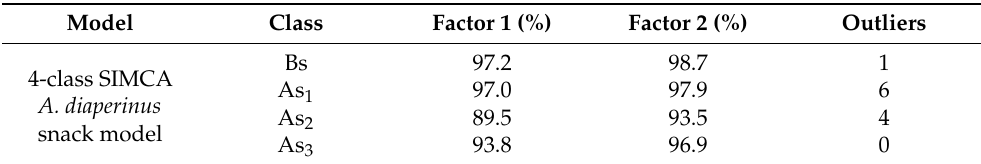
Table 8. The number of factors, their cumulative variance, and the number of outliers used to create a 4-class SIMCA model of A. diaperinus snacks.